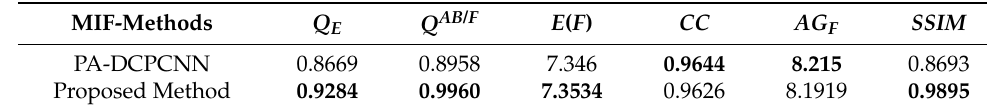
Figure 10. Multi-focus image of a desk from various perspectives. Original Image: ( a ), Multi-focus Input Images: ( b , c ), and Proposed Fusion: ( d ). Table 4. The results and comparisons for desk image